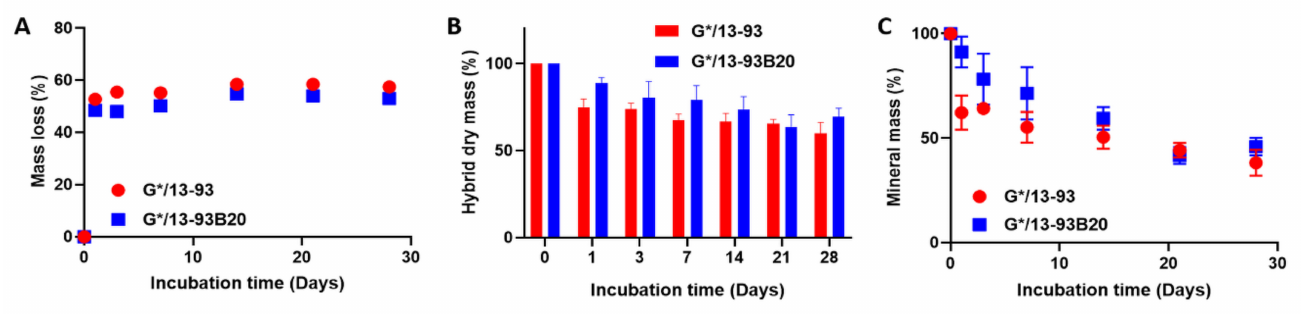
Figure 2. Mass loss ( A ), dry mass ( B ), and mineral mass ( C ) remaining in the hybrid G*/13-93 ( • ) and G*/13-93B20 ( | ) as a function of immersion time in